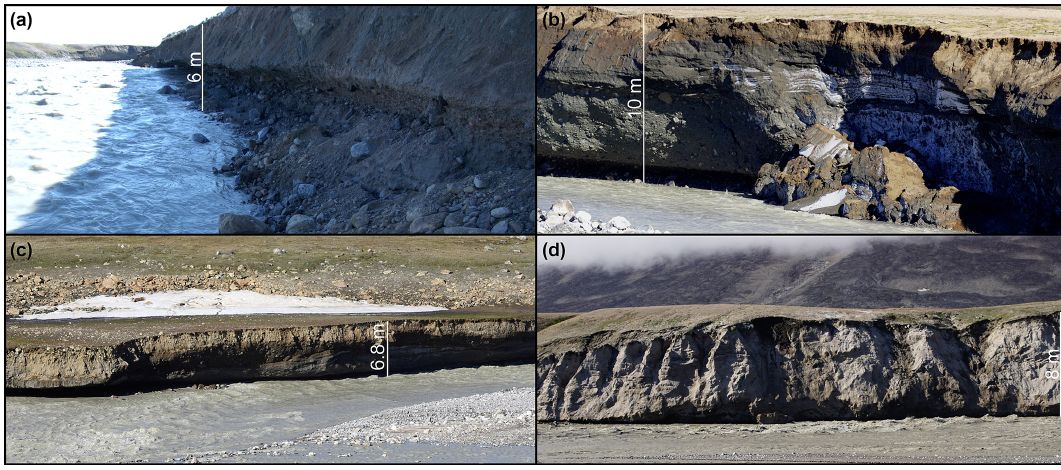
Figure 7. Examples of steep and undercut riverbanks.